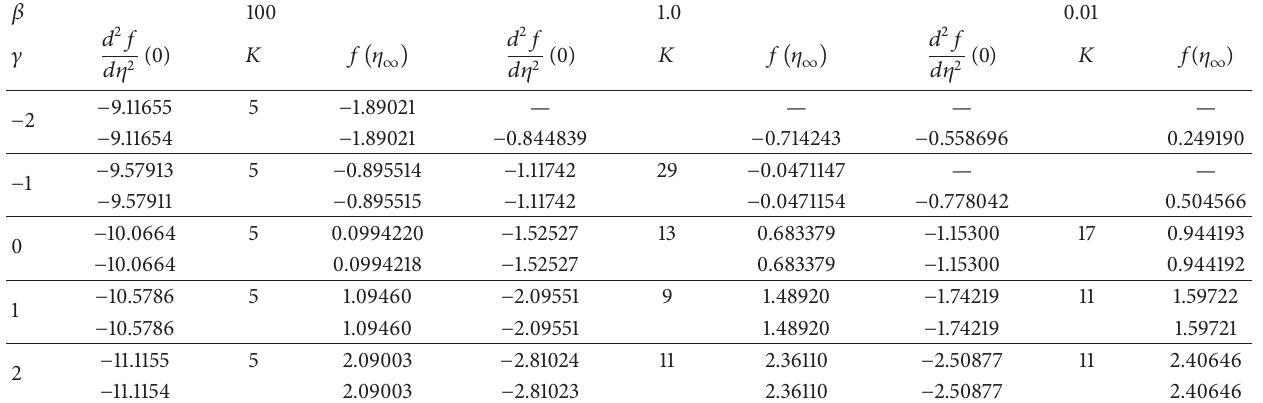
Table 2: Validity of the expansion solution at different values of 𝛽 and 𝛾 , 𝜆 = 1.5 ( 𝛼 = 3 ).